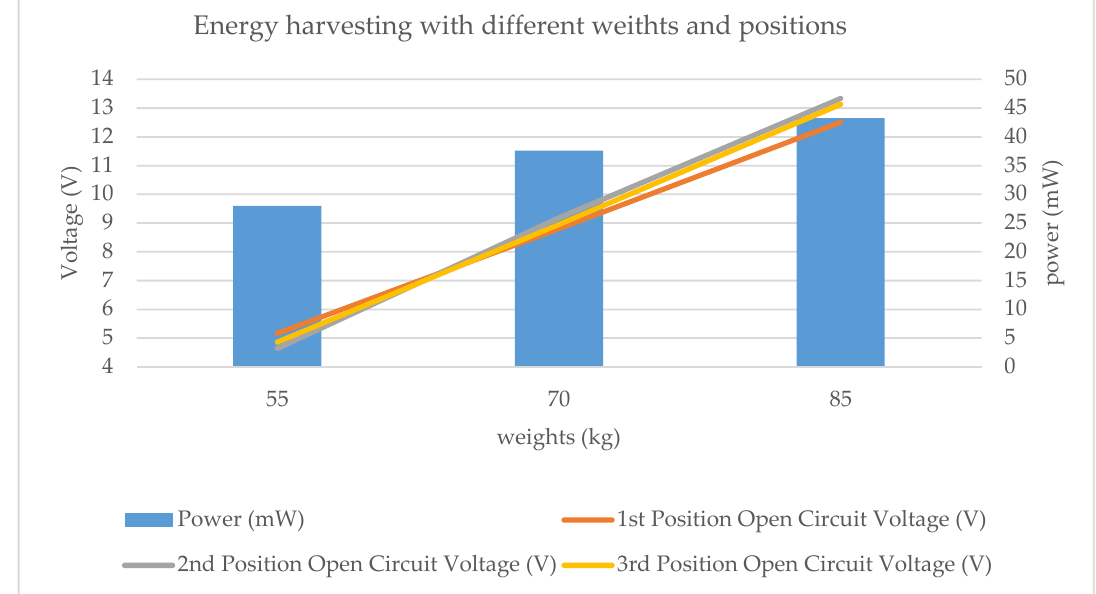
Figure 8. Output voltage generated with steps of people with different weight and positions.